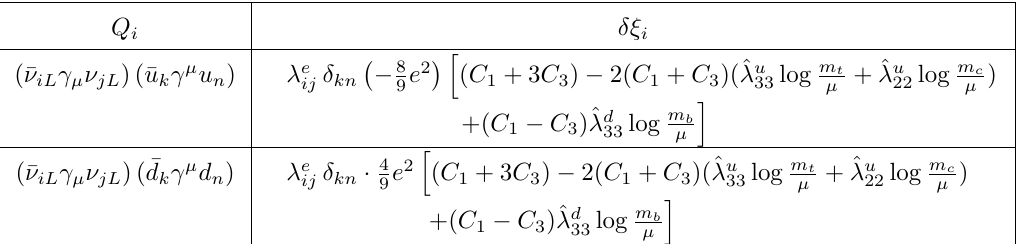
Table 7 . Operators Q i and coe(cid:14)cients (cid:14)(cid:24) i for the semileptonic part of the e(cid:11)ective Lagrangian (cid:14) L QED